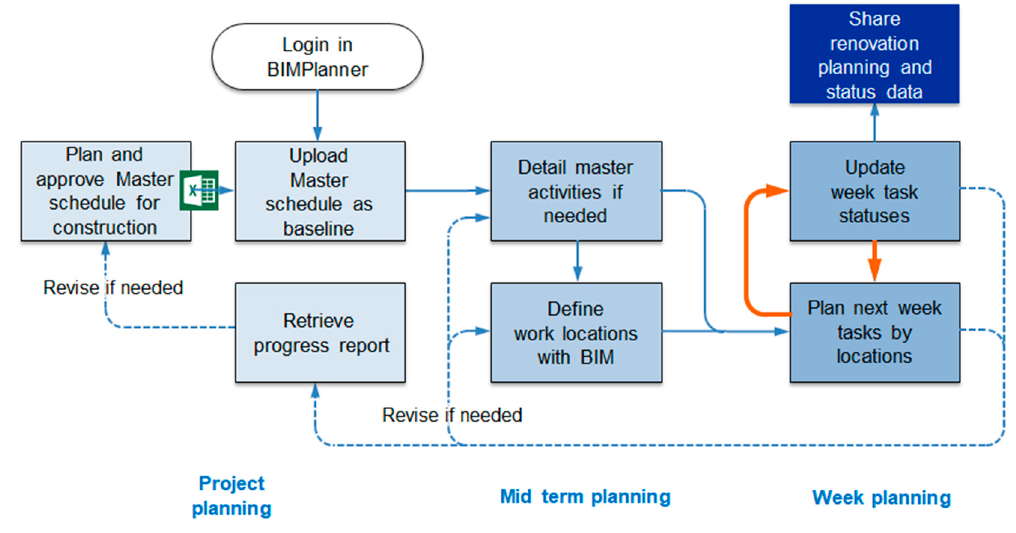
Figure 2. BIMPlanner use